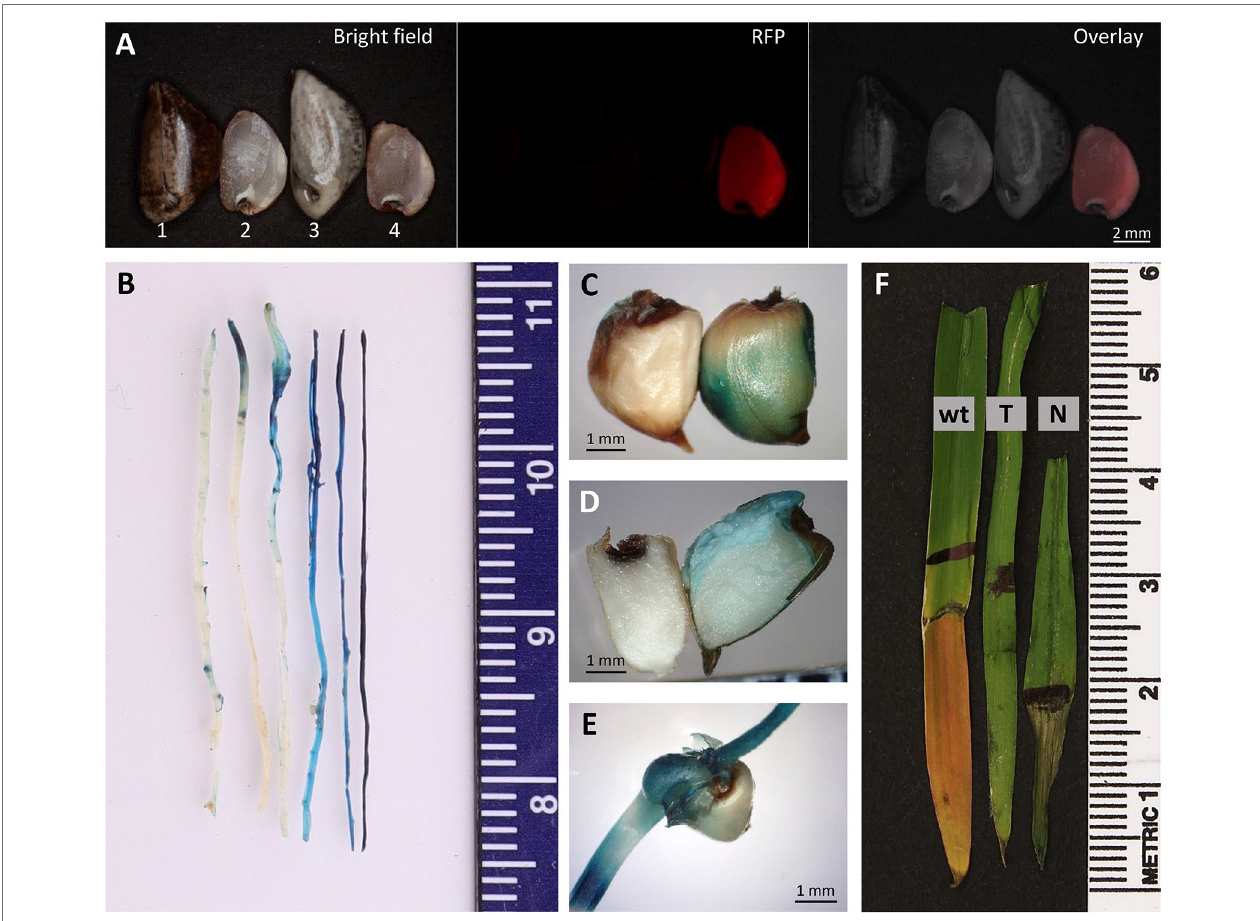
FIGURE 7 | Progeny analysis. (A) Images of intact (#1 and #3) and “naked” (#2 and #4) teosinte seeds of Bright field (left), RFP (center) and Overlay (right). “Naked” transgenic T1 seed of pKL2155 (#4) appears pink in Bright field. Seeds #1 and #2, wild-type teosinte; Seeds #3 and #4, transgenic event 2155-A T1 seeds. GUS assay performed on roots (B) , intact “naked” seeds (C) , half “naked” seed (D) and germinating shoot (E) of T2 transgenic teosinte of pAHC25 event. Blue color indicates the gus gene expression. (F) Herbicide leaf painting assay. Portion of the leaf surface was applied with 500 mg/L glufosinate plus 0.1% Tween-20 using a Q-tip. Image was taken 2 days after the herbicide-application. wt, wild-type teosinte seedling; T, herbicide resistant T2 transgenic seedling; N, herbicide sensitive T2 null